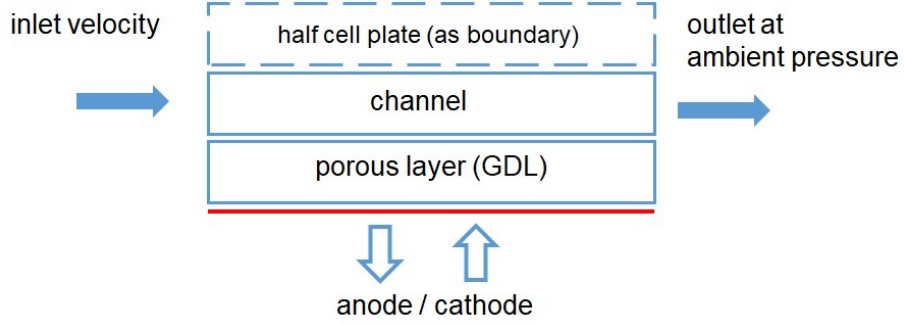
Figure 6. Sketch of the overall principle for the CFD simulations of anode and cathode plates.